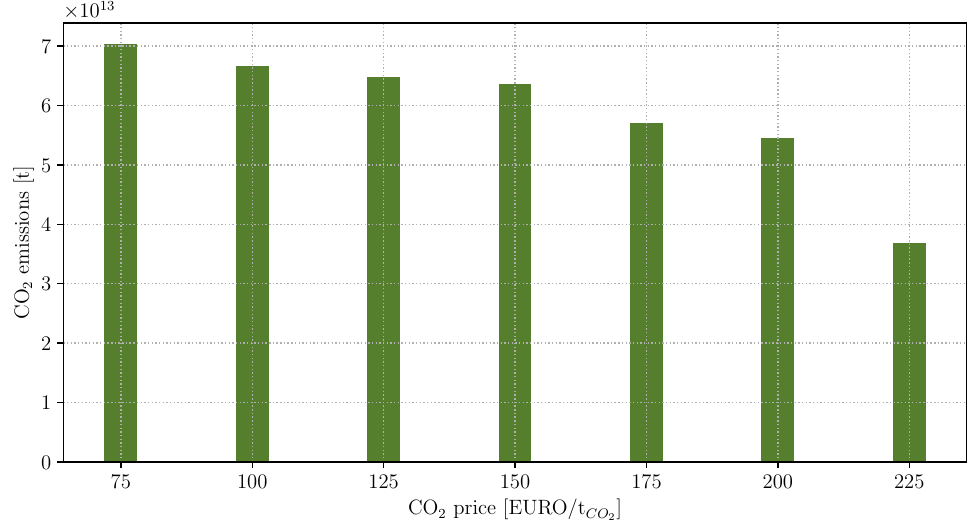
Figure 9. Illustration of CO 2 emissions for different assumptions of CO 2 emission prices. Table 8. Overview of the applied climate years 1982, 1984 and 2007. Data from [61]. Climate Year Demand Wind Solar Hydro Inflow Mid Low High Mid